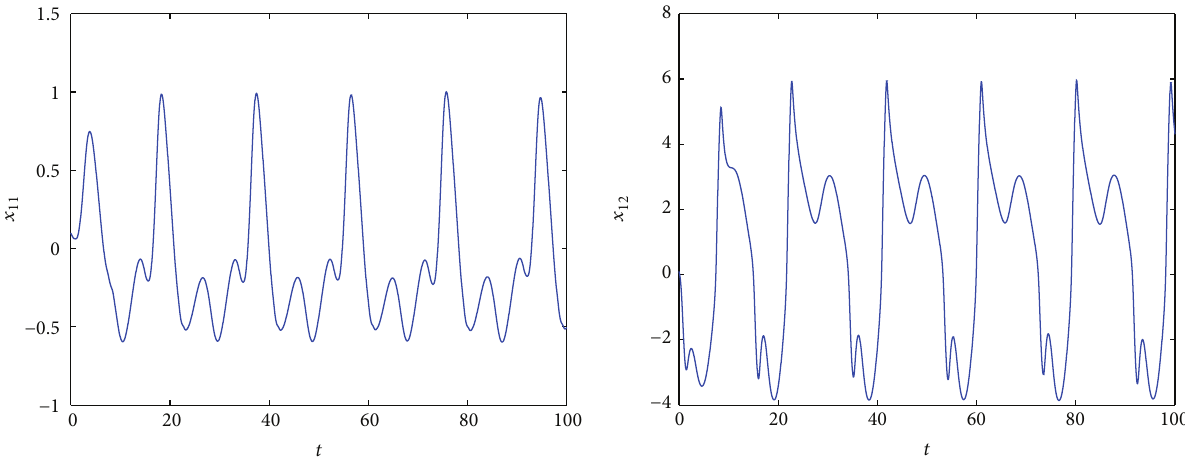
Figure 2: The state trajectories 𝑥 11 and 𝑥 12 of the first subsystem.